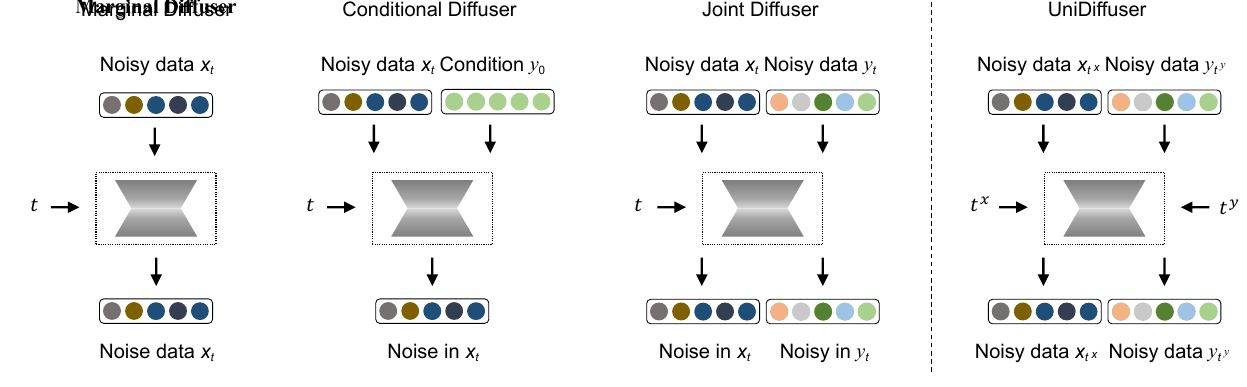
Figure 14 UniDiffuser adds noise to all modalities simultaneously [11]. Figure 2. Comparison with bespoken diffusers. UniDiffuser fits all distributions simultaneously with a minimal modification of Ho et al. (2020). In particular, it degenerates to bespoken diffusion models by setting the timesteps (or noise levels)